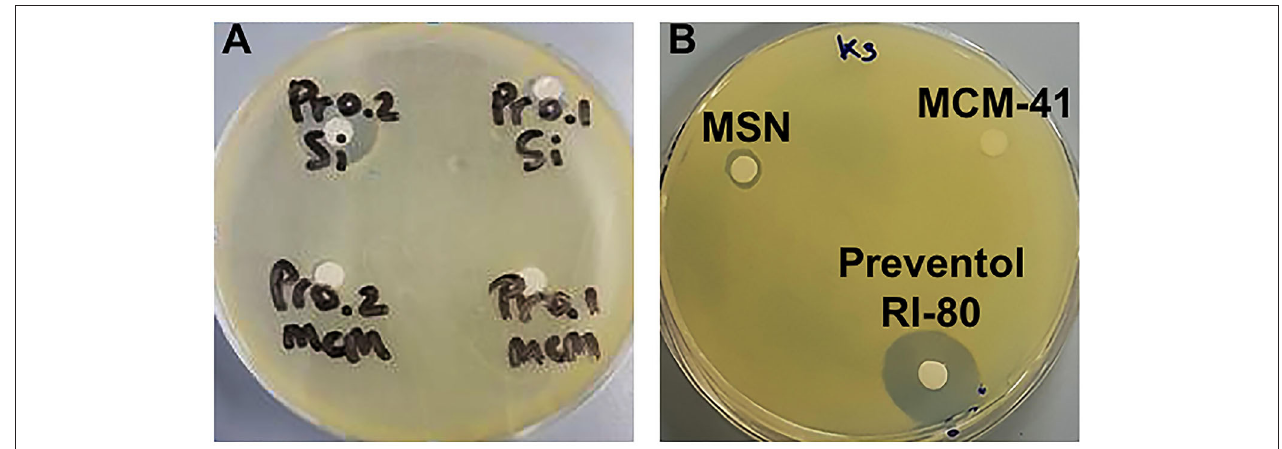
FIGURE 4 | Microbiological assays using K. rhizophila as a tester strain. Antibacterial activity (A) of Preventol RI-80 0.2@MCM-41 (Pr0.2MCM), Preventol RI-80 0.1@MCM-41 (Pr0.1MCM), Preventol RI-80 0.2@MSN (Pr0.2Si), and Preventol RI-80 0.1@MSN (Pr0.1Si), while in (B) is highlighted the effect of either unloaded MSN or MCM-41 systems, as well as Preventol RI-80.